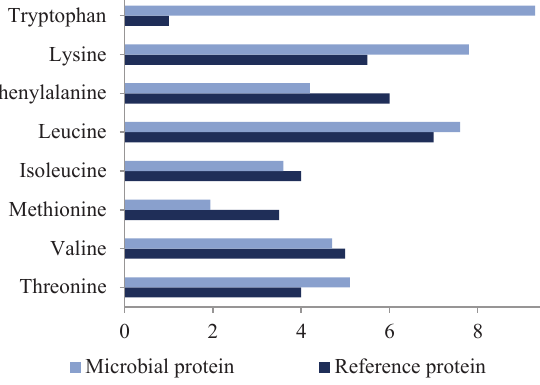
Figure 1 Essential amino acids in the protein of the microbial biomass mix ( Aspergillus oryzae and Sаcharomyces cerevisiae ) vs. reference